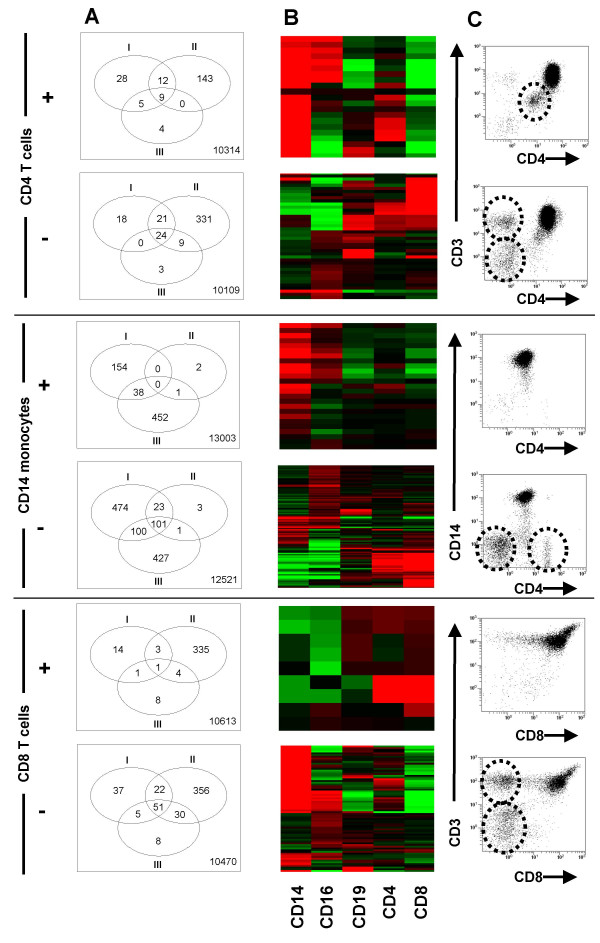
Differential gene expression following positive or negative selection reflects cellular contamination rather than activation. (A) Venn diagrams showing number and overlap of statistically significant, differentially expressed genes (as defined in materials and methods) in each independent experiment (roman numerals). The number in the bottom right of each panel is the number of genes whose expression does not change with selection. Genes whose expression changes upon positive (+) or negative (-) selection are shown for each cell type. (B) Heat diagrams show the relative expression pattern of genes significantly changed in 2 out of 3 replicates in 3A on arrays of purified cell subsets from Figure 1A. Red indicates over-expression and green indicates under-expression. (C) Representative flow cytometry profiles for each positively and negatively purified cell type. Putative contaminating cell populations that correlate with the gene expression patterns observed in 3A are ringed (------).